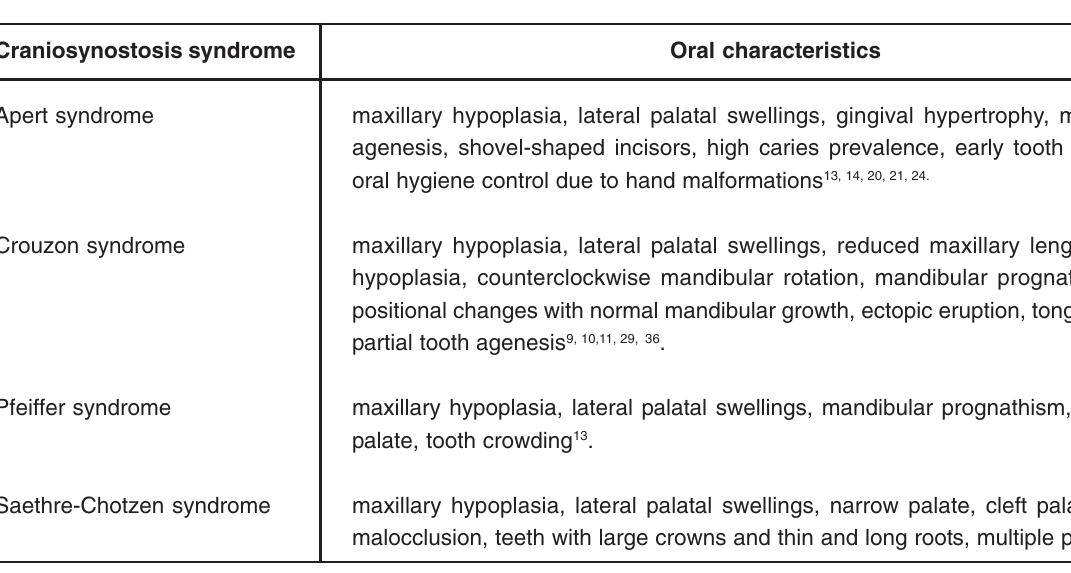
FIGURE 1- Oral characteristics of craniosynostosis